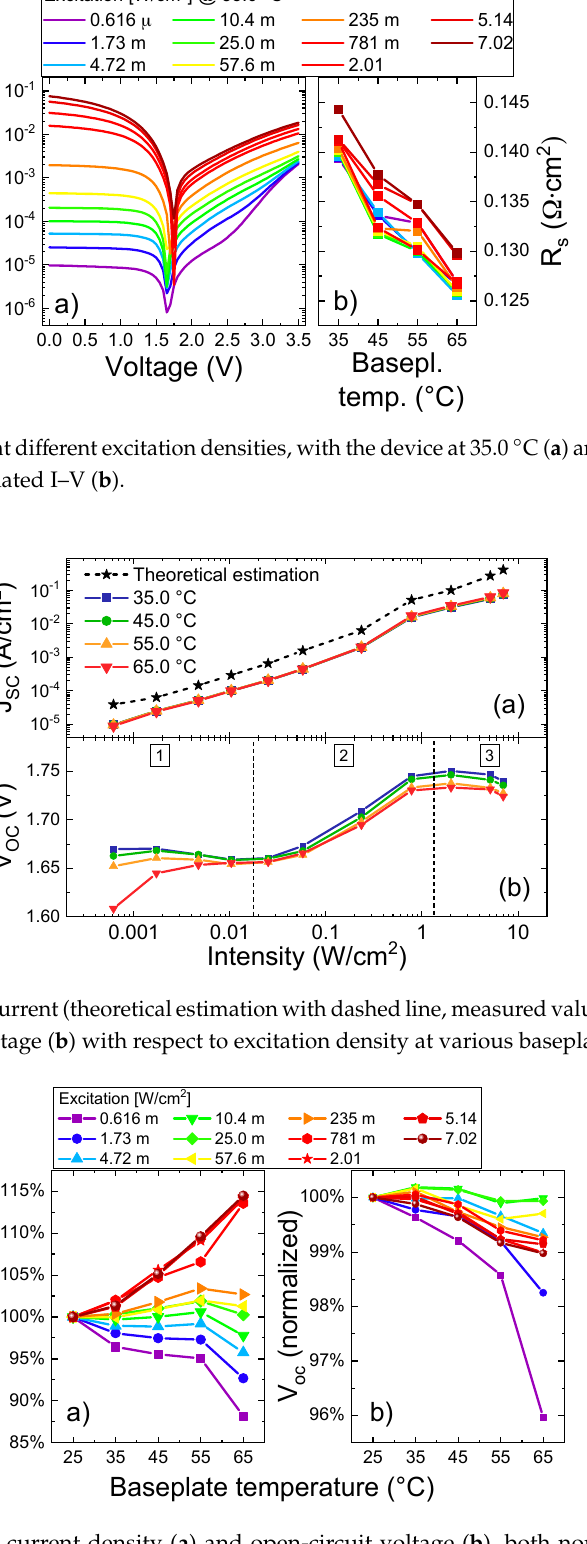
Figure 5. Short-circuit current density ( a ) and open-circuit voltage ( b ), both normalized at 25 °C, with respect to baseplate temperature at various excitation densities.